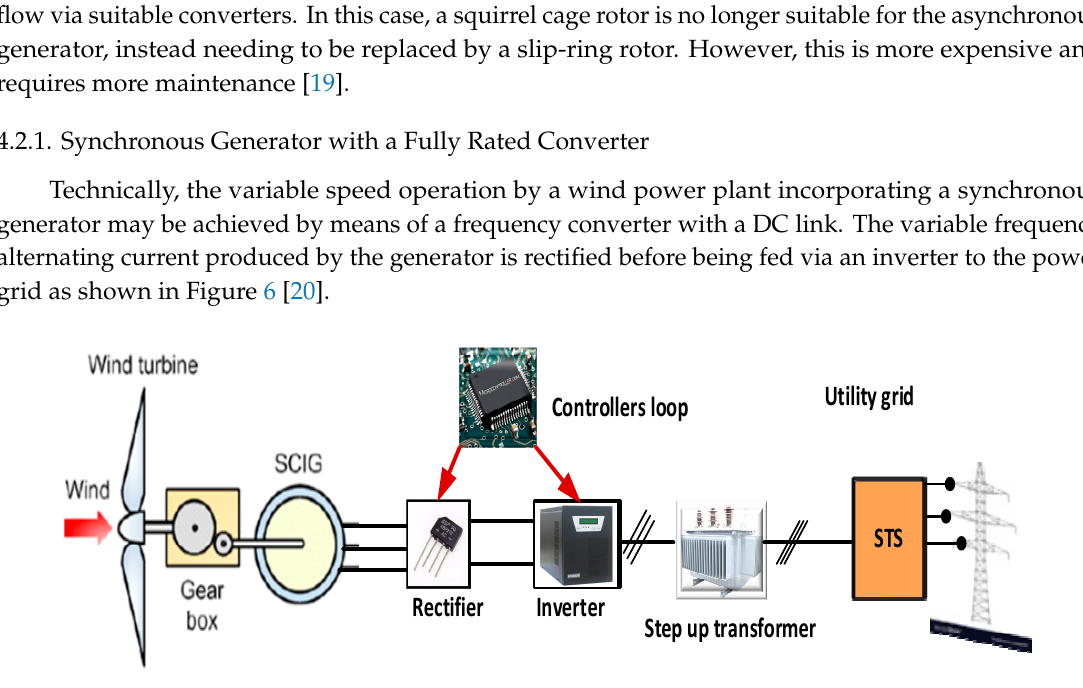
Figure 5. Schematic diagram of a wind turbine with a fixed speed.